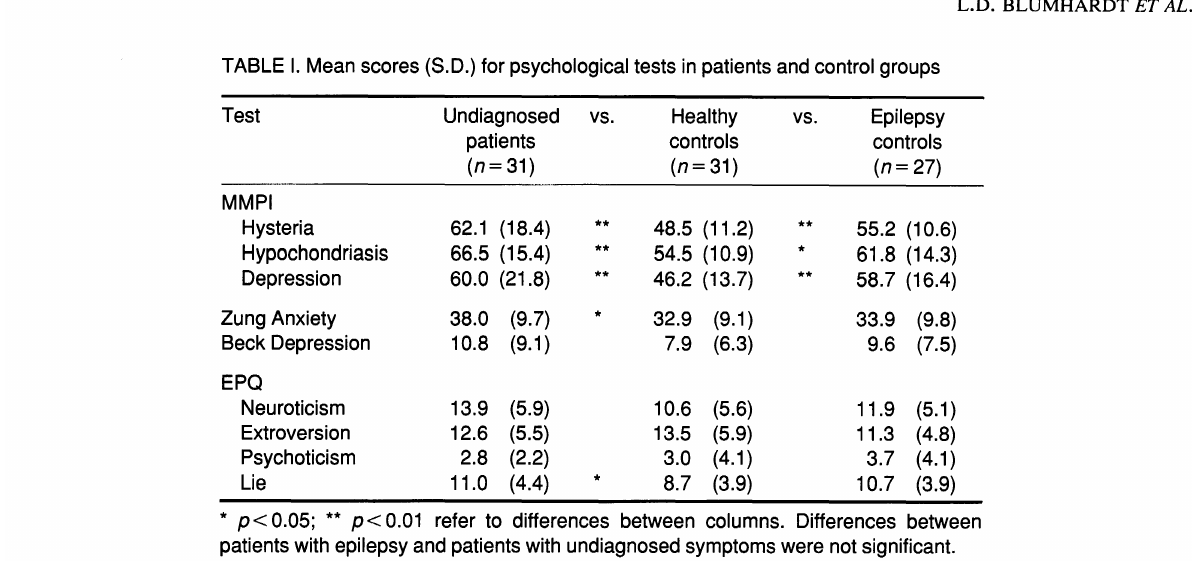
TABLE I. Mean scores (S.D.) for psychological tests in patients and control